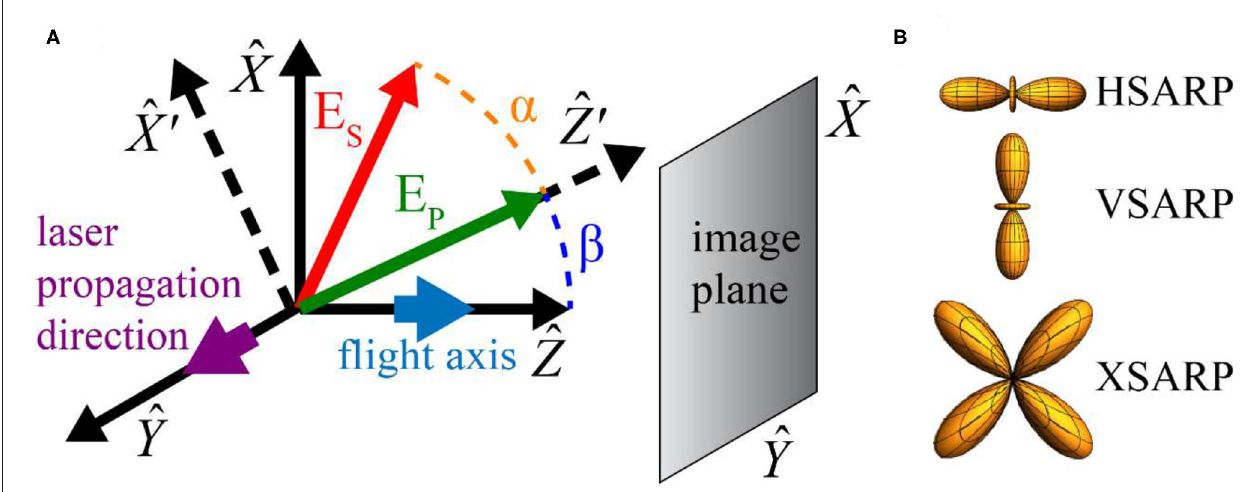
FIGURE 1 | (A) The coordinate system used in this paper. The Z axis is the direction of the molecular beam, which defines the collision velocity, while the laser propagates along the Y axis. The polarization of the pump and Stokes lasers are in the XZ plane, and their directions are given by the angles β and α . The scattered particles are imaged in the XY plane. (B) Axis distributions for the three specific alignment states discussed in the paper shown with the plane of the page as the XZ